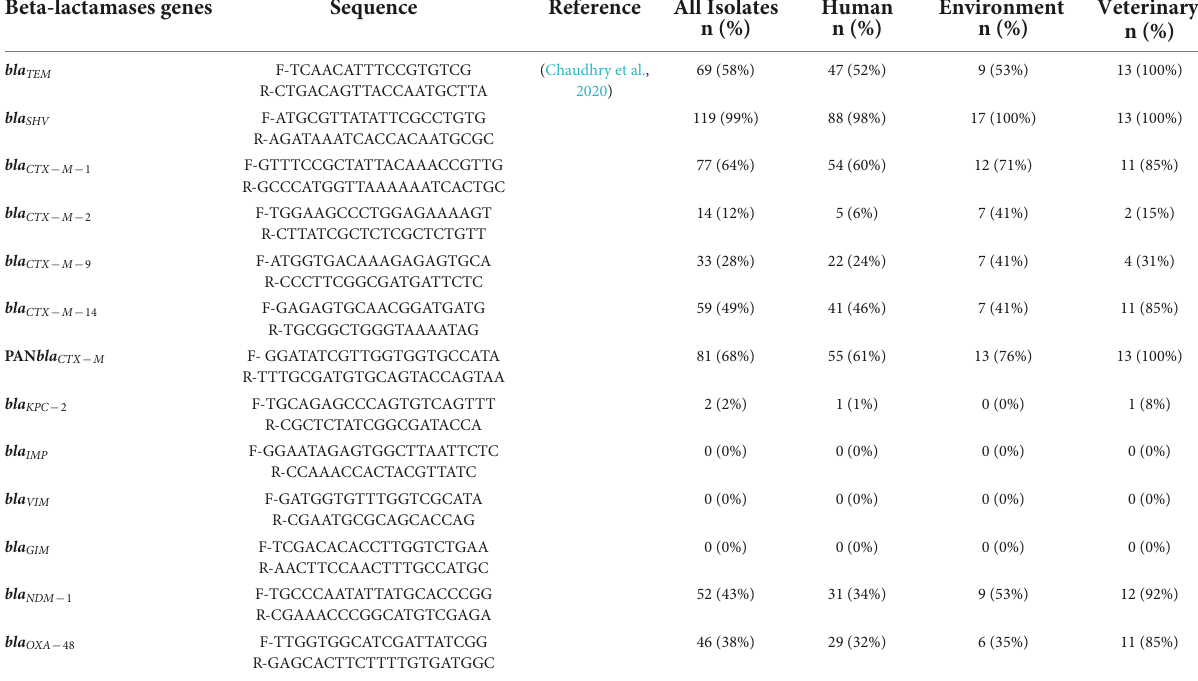
TABLE 3 Prevalence of all beta-lactamases genes found in isolates from different sources. Beta-lactamases genes